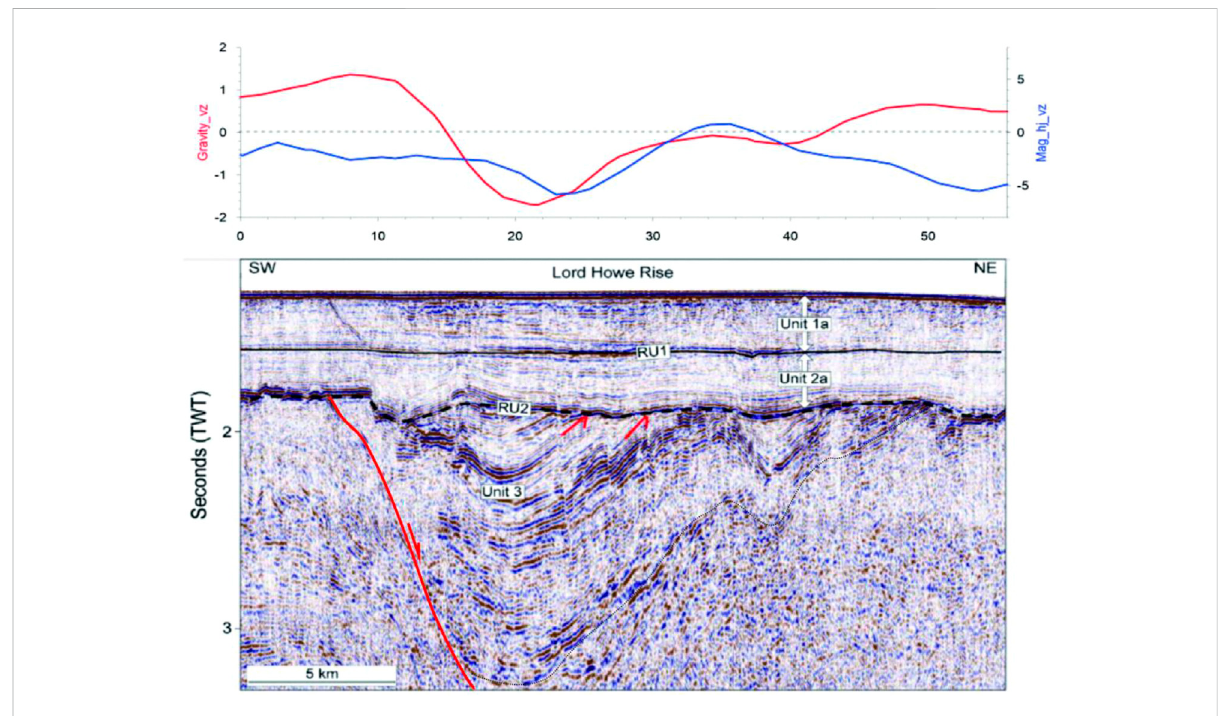
FIGURE 3 Seismic pro fi le with gravity – magnetic